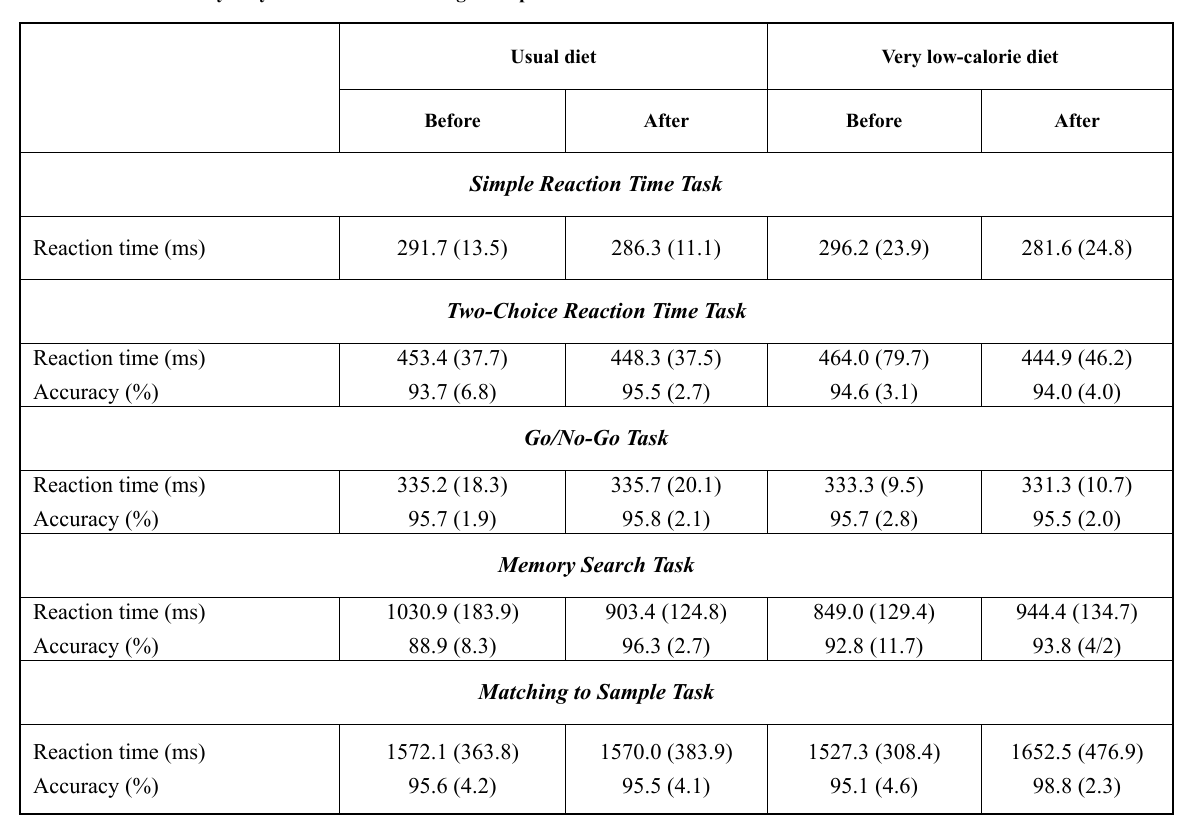
Table 4. Effect of a 2-day very low-calorie diet on cognitive